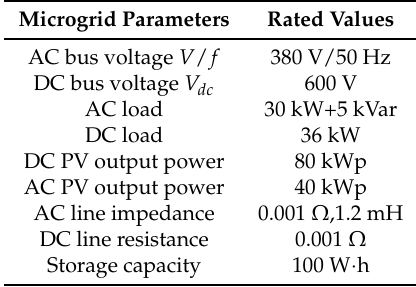
Table 1. System simulation